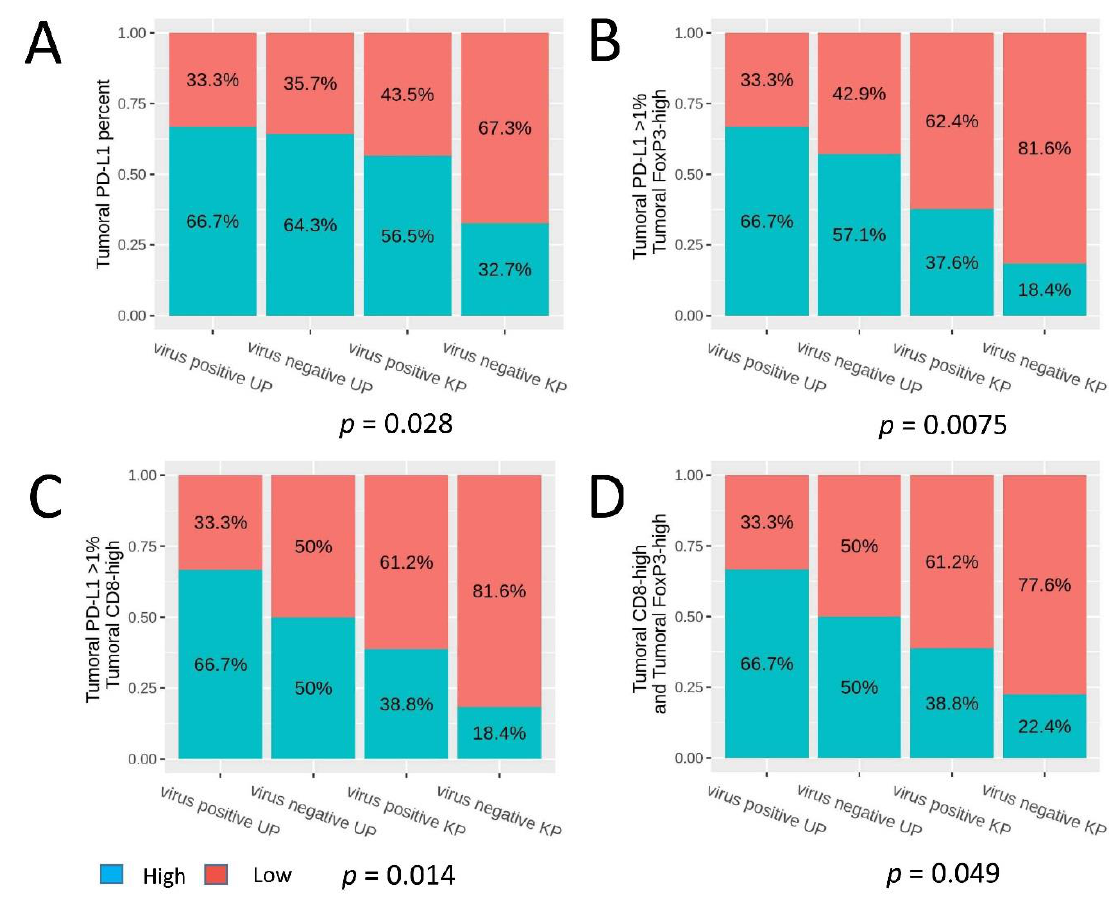
Figure 4. Comparisons of ( A ) tumoral PD-L1 expression and high coexpression of ( B ) PD-L1 and CD8, ( C ) PD-L1 and FoxP3, and ( D ) CD8 and FoxP3 in the four groups: MCPyV-positive unknown primary (UP); MCPyV-negative UP; MCPyV-positive known primary (KP); and MCPyV-negative KP.